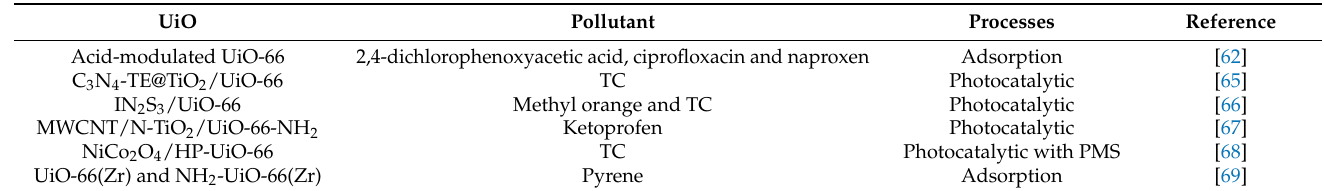
Table 3. Applications of UiO-MOF in wastewater